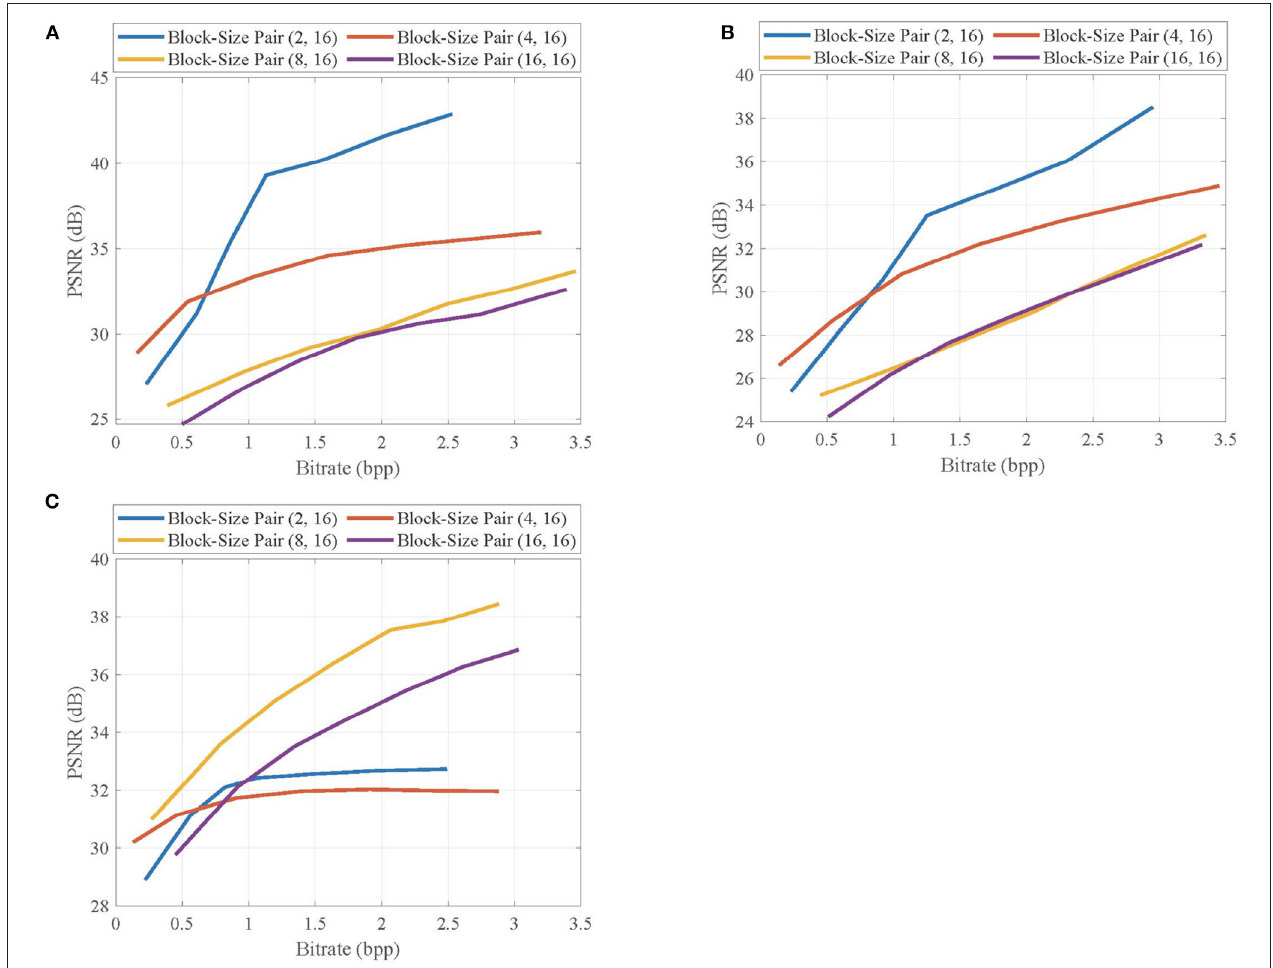
FIGURE 7 | Rate-distortion curves of the reconstructed key frames in (A) Foreman , (B) BlowingBubbles , and (C) ParkScene sequences at different block-size pairs.